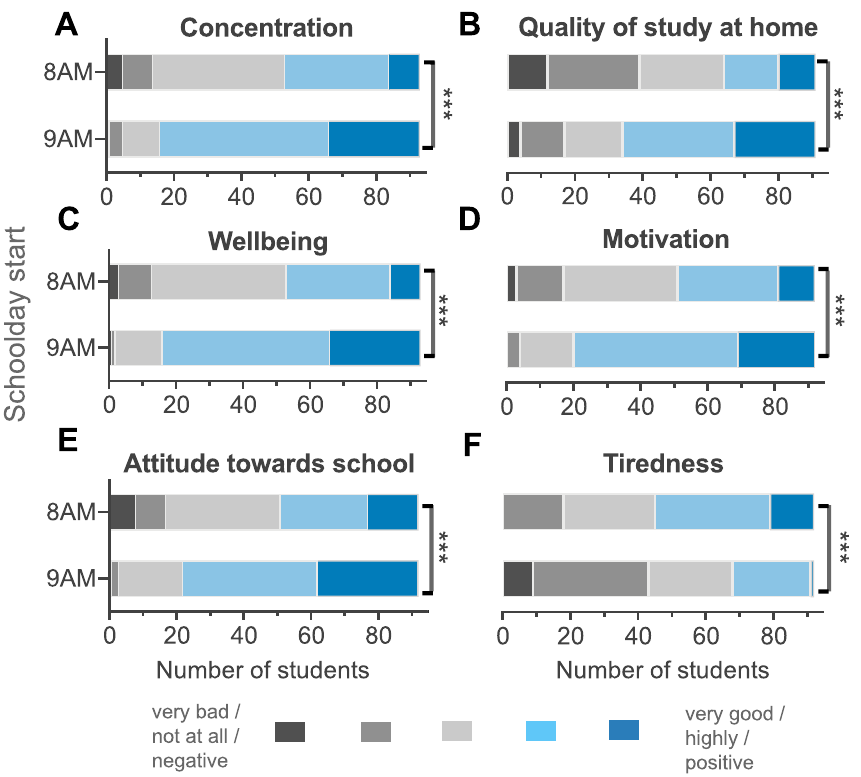
Figure 3. Comparison of subjective psychological benefits between 8AM-days and ≥ 9AM-days in the flexible system. Results from the survey at end of wave 2 asking cohort 2 for the following ratings: ( A ) ability to concentrate during class (Z = 6.419, d = 1.784, n = 93), ( B ) quality of study at home after school (Z = 6.055, d = 1.643, n = 91), ( C ) general wellbeing (Z = 6.559, d = 1.855, n = 93), ( D ) motivation to attend school (Z = 5.927, d = 1.572, n = 92), ( E ) attitude towards school (Z = 5.896, d = 1.545, n = 92), and ( F ) tiredness during class (Z = 5.419,d = 1.369, n = 92). Wilcoxon signed rank test, *p < 0.05, **p < 0.01, ***p <